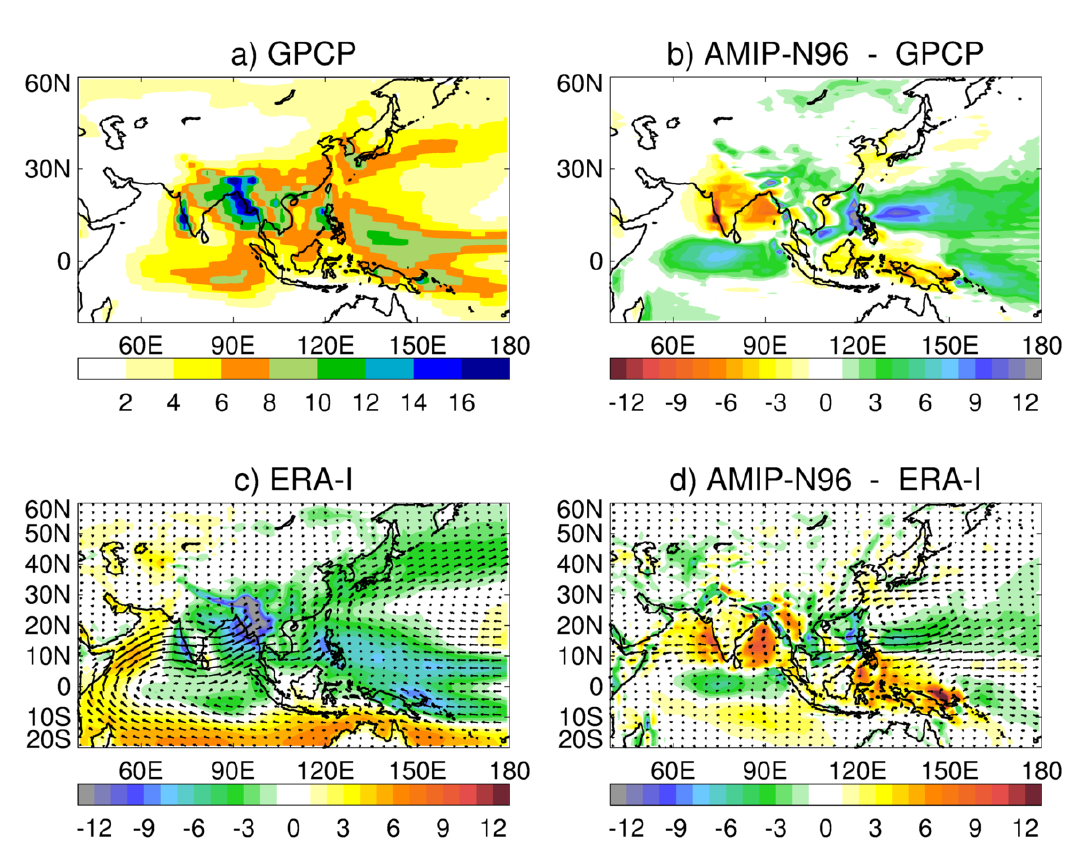
Figure 1. June–August 1988–2007 mean values of: ( a ) GPCP precipitation; ( b ) AMIP-N96 precipitation error with respect to GPCP; ( c ) ERA-I atmospheric moisture divergence (shaded) superimposed to moisture flux vector (arrows); ( d ) AMIP-N96 moisture flux and divergence errors with respect to ERA-I. All values are expressed in mmday − 1